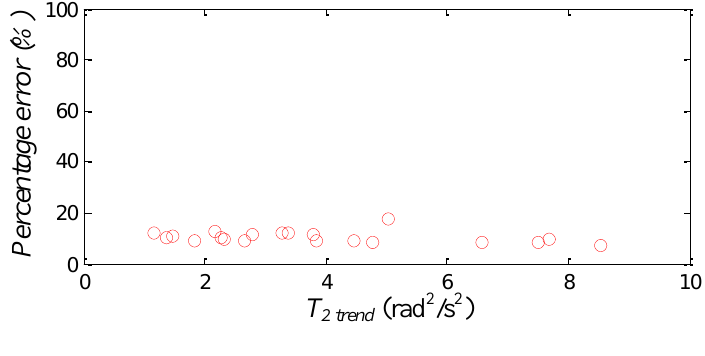
and the ratio of RMSE and amplitude of angular 2